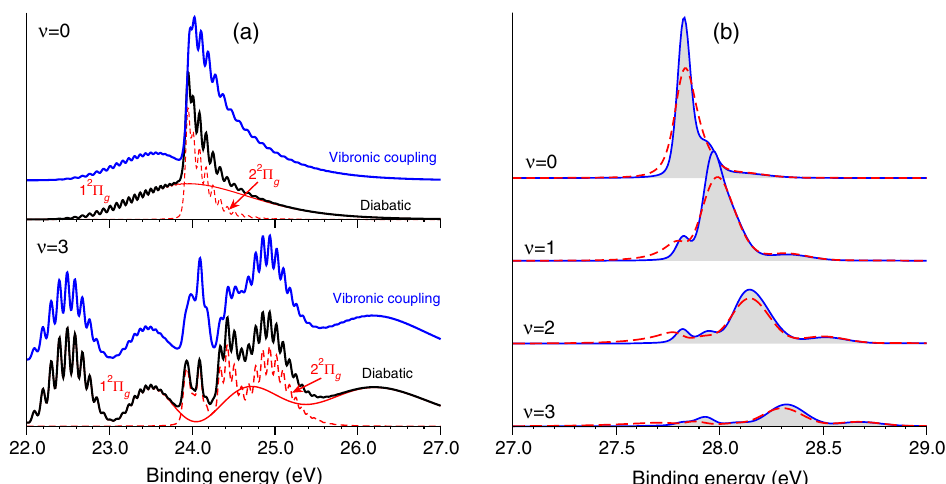
FIG. 9. (a) RPE spectra related to the isolated 1 2 (cid:2) coupling between them. (b) Total theoretical RPE profiles related to the 2 (cid:2) adiabatic (dashed lines) PECs (see Fig.